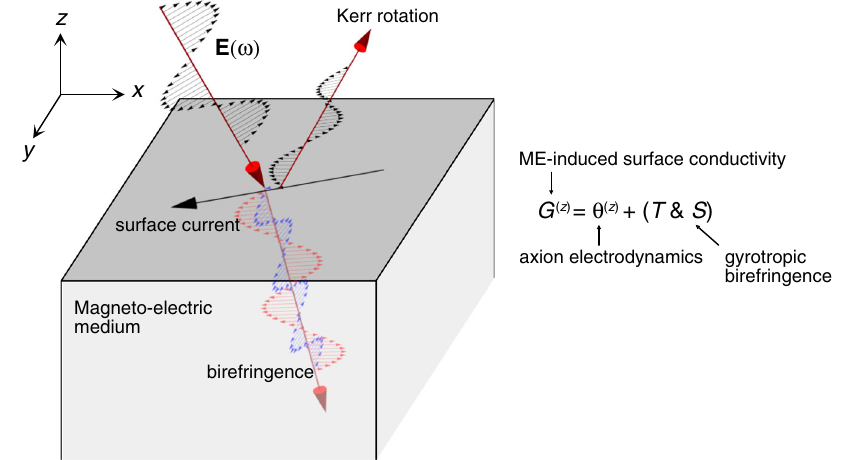
spatially varying θ parameter, S OA =( e 2 /2 π h ) ∫ θ ( x ) E ⋅ B . Integrating by parts in the presence of an interface along the z direction where the axion angle jumps at the interface δθ andidentifyingthecoef fi cientof A i